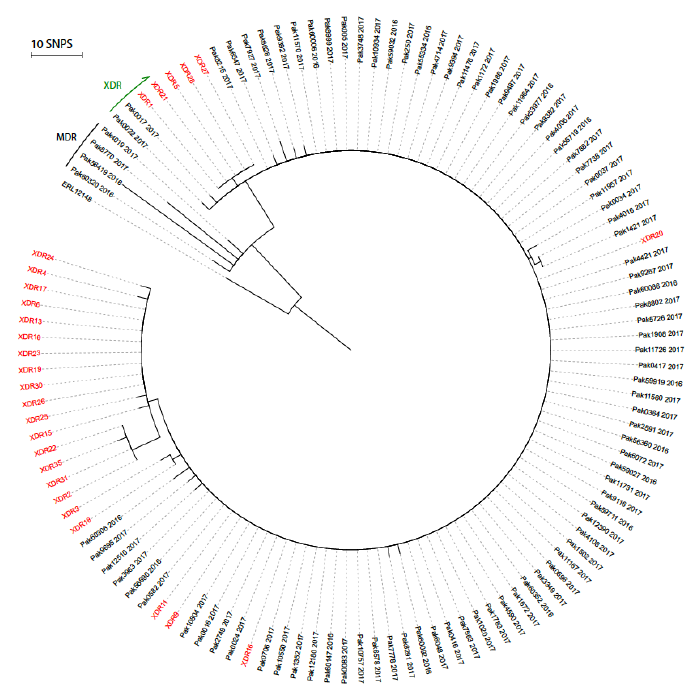
Figure 1. Phylogenetic tree of XDR S . Typhi. Radial phylogram of maximum-likelihood phylogeny (RaxML) rooted to S . Typhi ERL12148 (accession LT883153.1). PAK strain numbers in black are from [5] and XDR strain numbers (red) are from Lahore (this study). Black bar labeled MDR, indicates MDR strains and green arrow indicates that all strains from PAK0022 clockwise to XDR24 are XDR. Microorganisms 2020 , 8 , x FOR PEER REVIEW Analysis of all 27 draft genome sequences from Lahore indicated the presence of both an IncY plasmid and the CTX-M-15 determinant associated with ceftriaxone resistance. The CTX-M-15 resistance determinant was located on an IncY plasmid in the Southern Pakistan outbreak strains; our BRIG analysis suggested that this was also the case for the Lahore isolates (Figure 2).